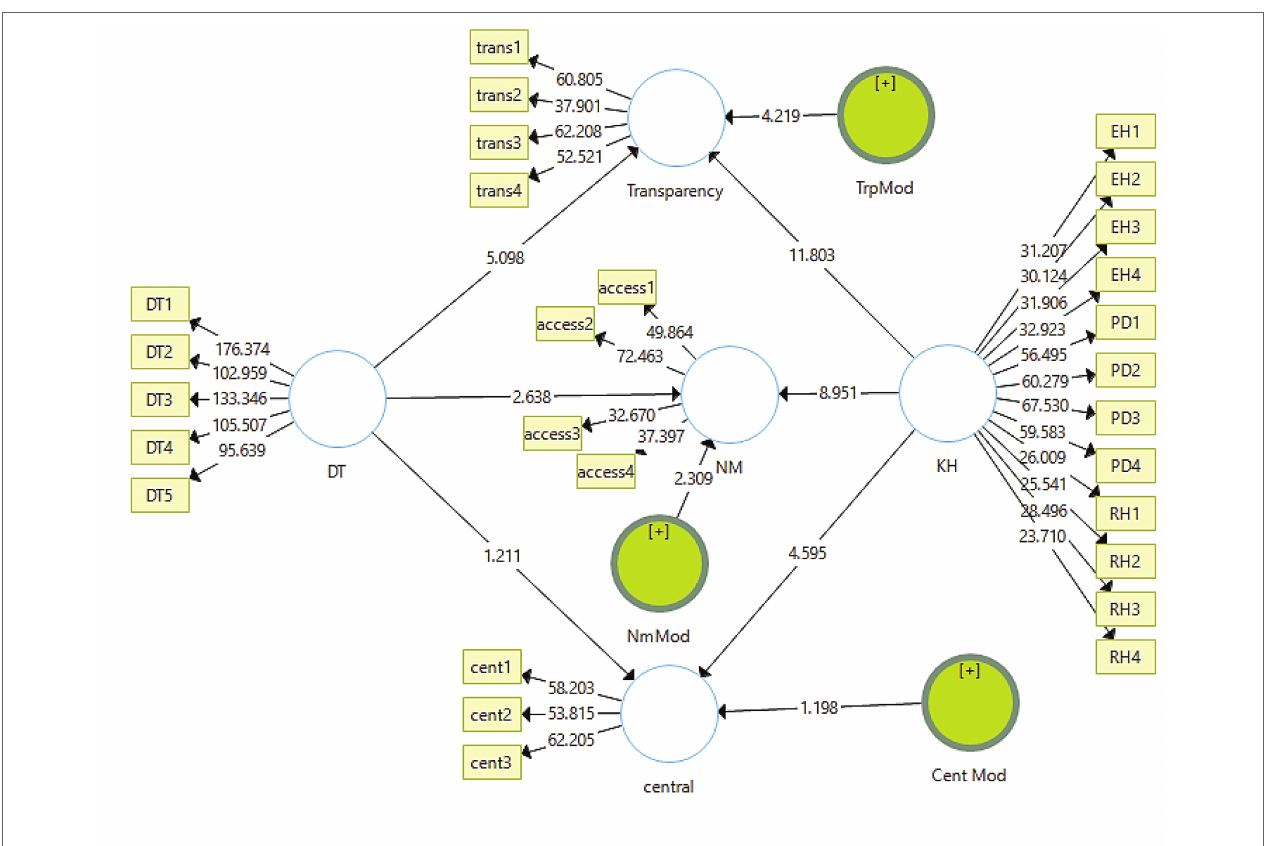
FIGURE 3 | Graphical model for bootstrapping algorithm.